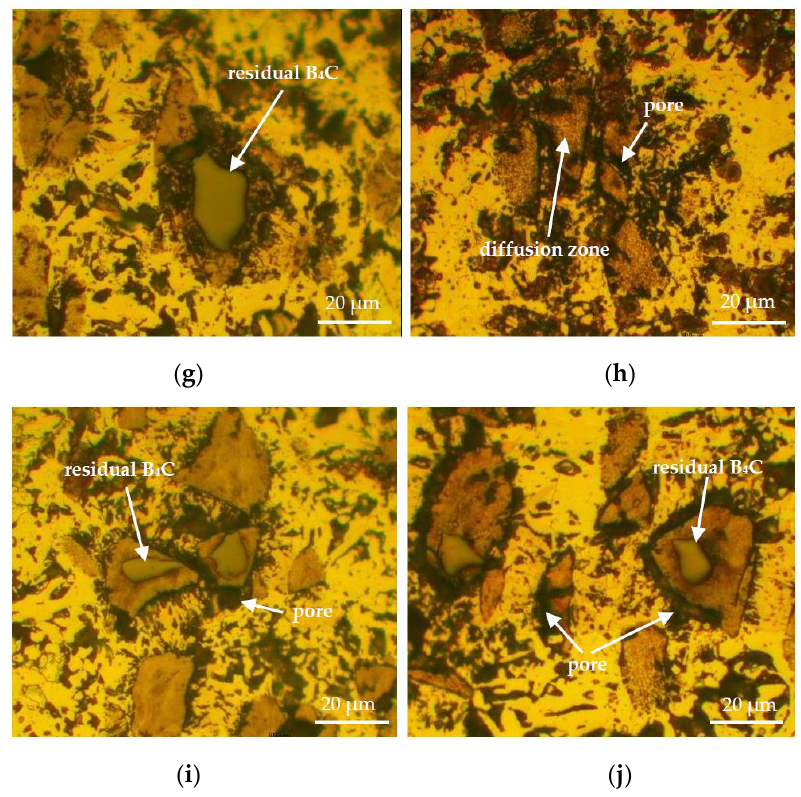
Figure 5. Optical micrographs of sintered Fe/B 4 C specimens: un-reinforced iron composites sintered for ( a ) 30 min and ( b ) 60 min (R0T30, R0T60); Fe + 5 vol.% B 4 C sintered for ( c ) 30 min and ( d ) 60 min (R5T30, R5T60); Fe + 10 vol.% B 4 C sintered for ( e ) 30 min and ( f ) 60 min (R10T30, R10T60); Fe + 20 vol.% B 4 C sintered for ( g ) 30 min and ( h ) 60 min (R20T30, R20T60); Fe + 30 vol.% B 4 C sintered for ( i ) 30 min and ( j ) 60 min (R30T30, R30T60).